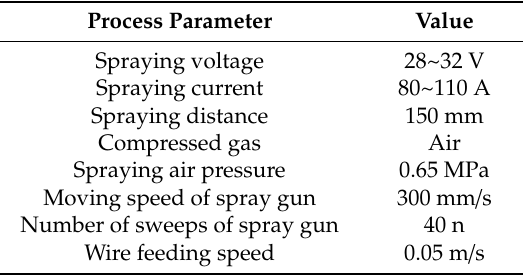
Table 1. Arc spraying process parameters.